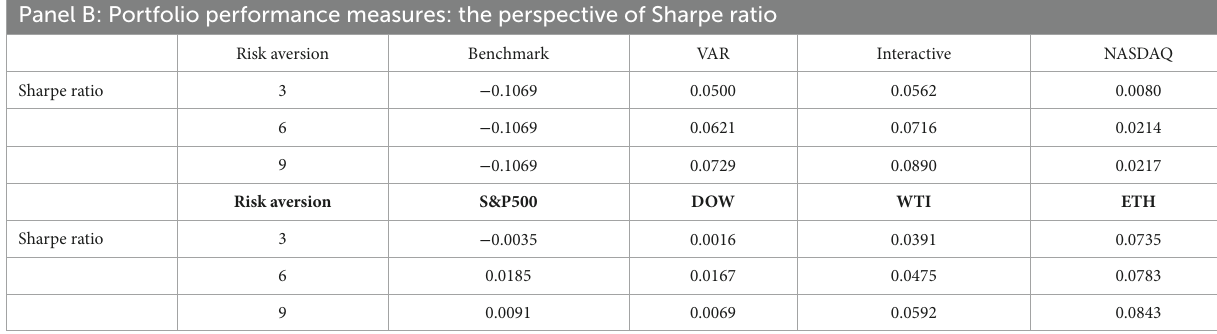
Panel B: Portfolio performance measures: the perspective of Sharpe